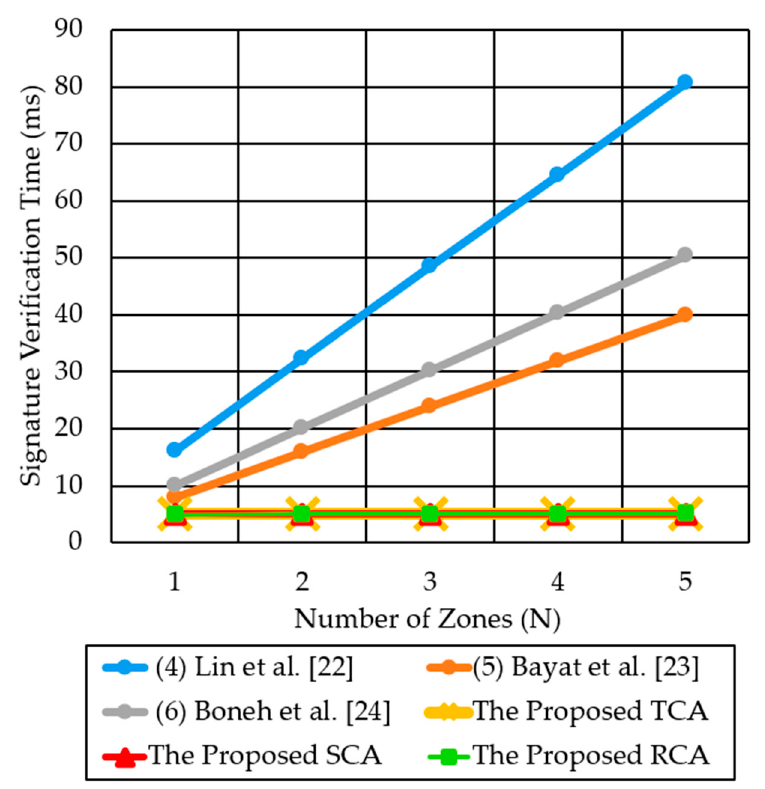
Figure 15. Comparison of signature verification time for the three proposed authentication methods and the two previous methods for multi-zone scenarios.